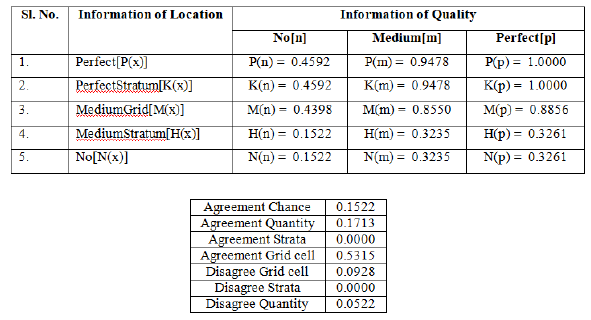
Table 6. Agreement/disagreement according to ability to specify accurately quantity and location to predict 2007 LULC